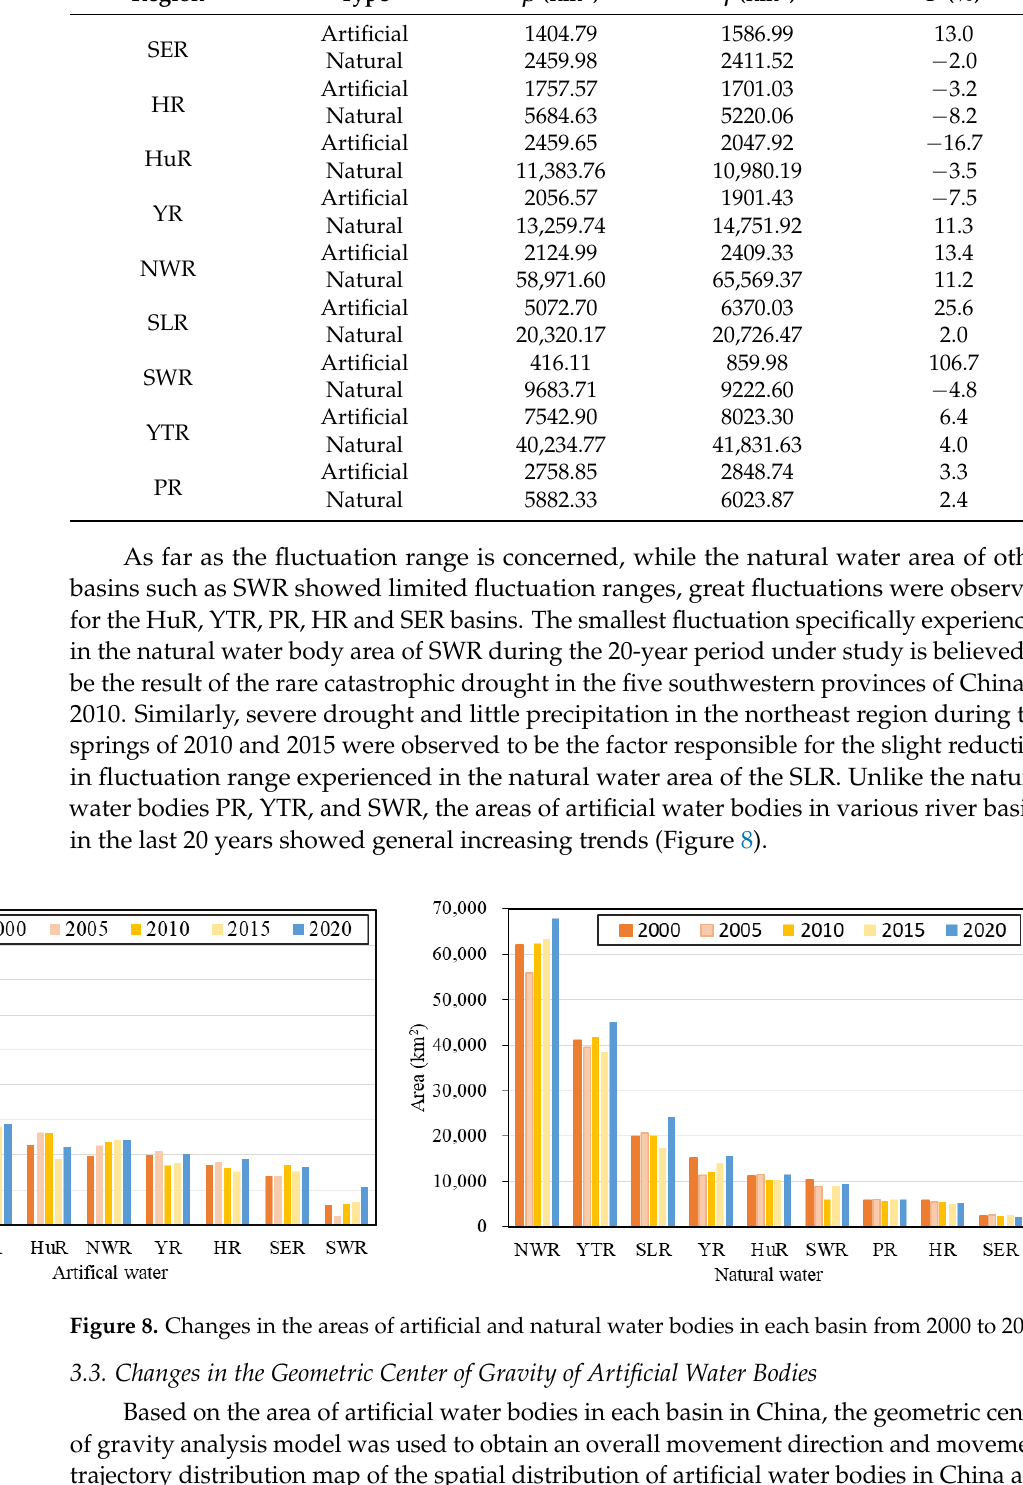
Table 4. Variation trends of artificial and natural water bodies in each basin from 2015 to 2020 com- pared with 2000 to 2005.